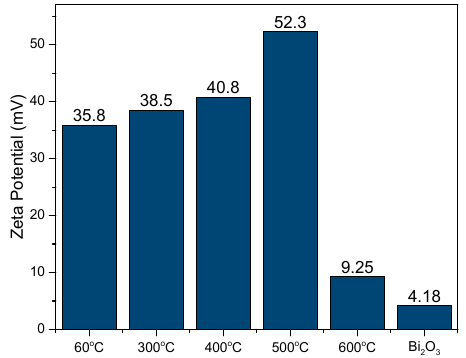
Figure 11. Zeta potential analysis of BiVO 4 microspheres.